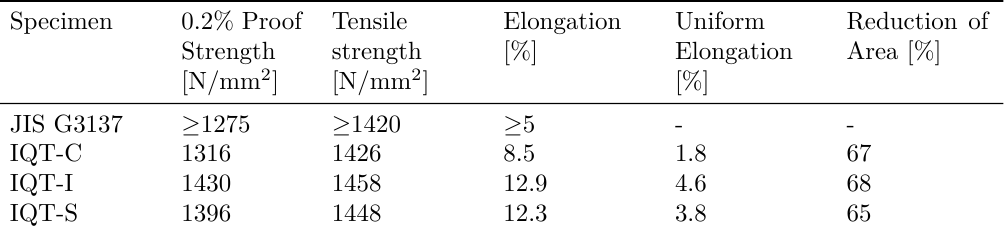
Table 2. Mechanical